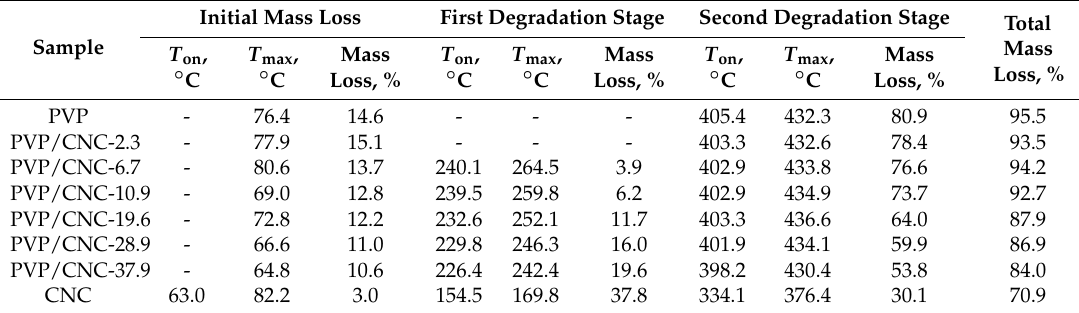
Table 1. Results of TG analysis of the PVP/CNC composite films.